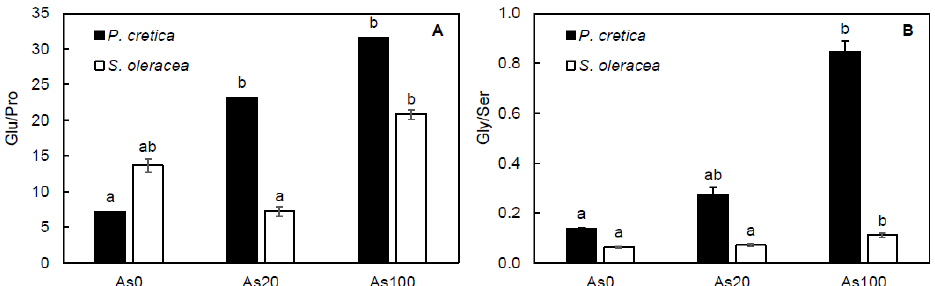
Figure 6. Effect of As treatments on the ratio of free glutamic acid and free proline ( A ) and ratio of free glycine and free serine ( B ) in Pteris cretica and Spinacia oleracea shoots in a pot experiment. Values represent the mean ± SE of three biological and four technical replicates per sample. Data with the same letter are not significantly different. Different letters indicate significant differences ( p ≤ 0.05) among treatments according to the Kruskal-Wallis test. Abbreviations: control—0 mg As/kg